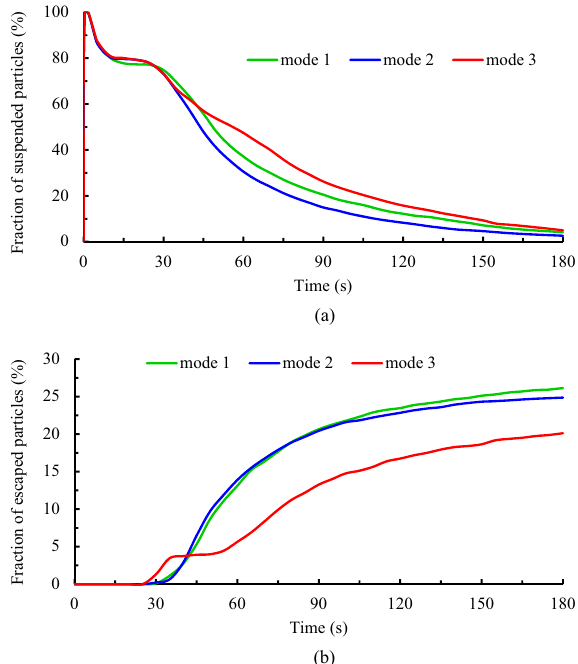
Figure 17. Effects of the air-conditioner location on the dispersion of the particles during scenarios 11 through 13; ( a ) variation of the suspended particles versus time and ( b ) variation of the escaped particles versus